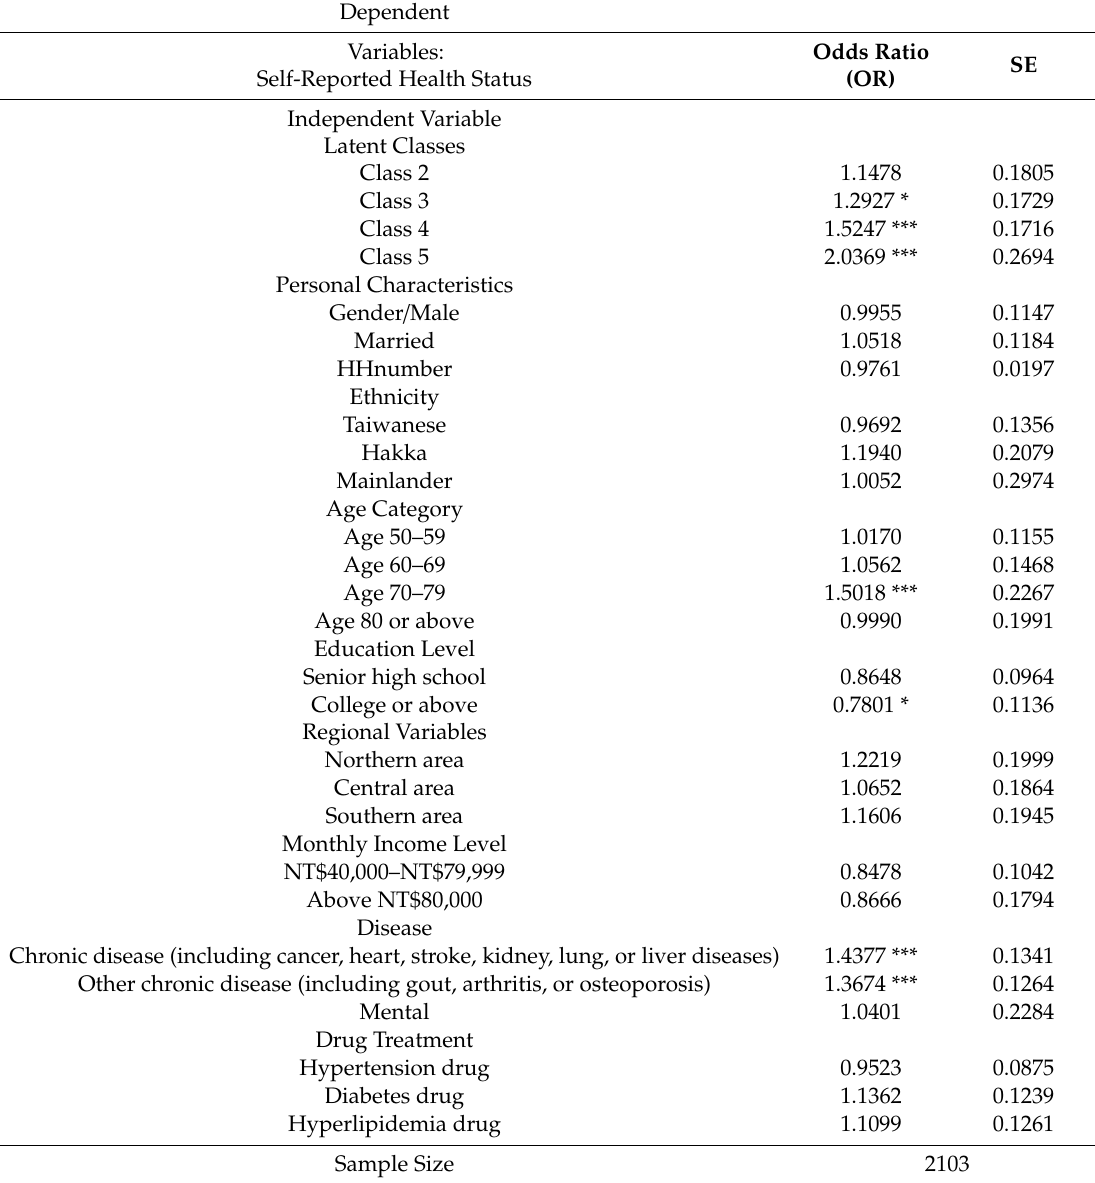
Table 6. Ordered logit regression on self-reported